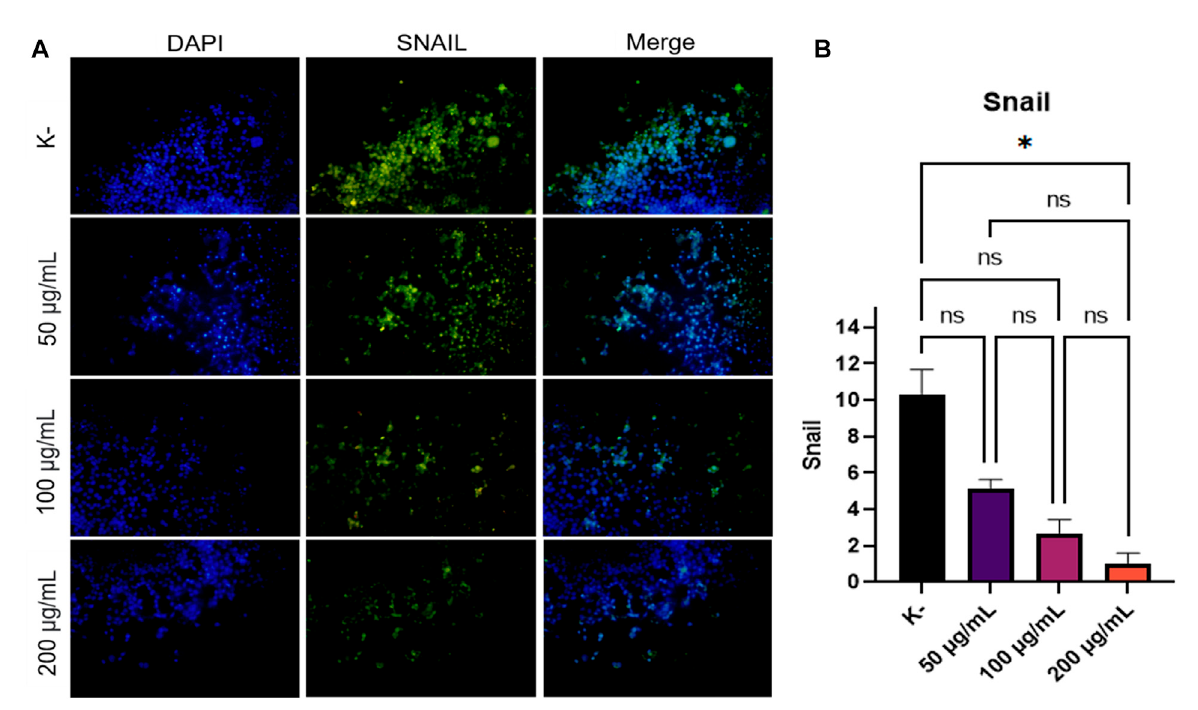
FIGURE 2 DecreasedSnailexpressionaftertreatmentwithvariousdosesof C.racemosa extractobservedbyimmuno fl uorescence. (A) ExpressionofSnail (green)comparedwithDAPI(blue)onimmuno fl uorescenceassay. (B) Snailexpressiondataarepresentedintermsofmean±standarddeviation,* p